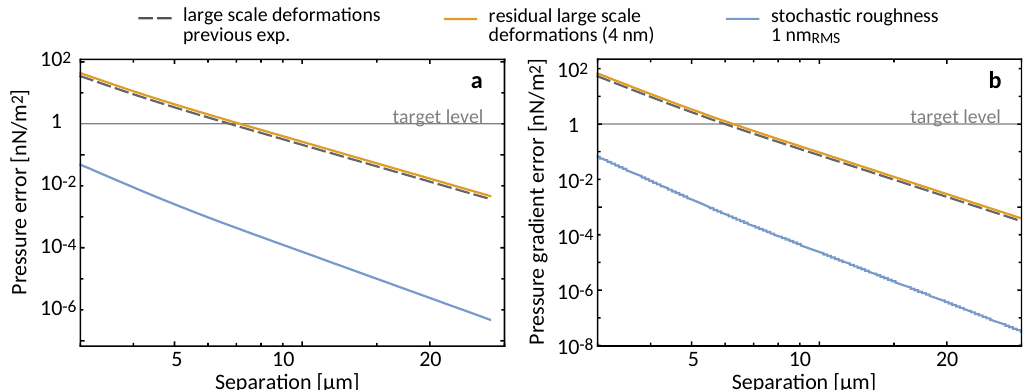
Figure 3. Errors δ P corr of the pressure ( a ) and δ P (cid:48) corr of the pressure gradient ( b ) due to residual large scale deformations of the plates. For reference, the targeted sensitivity level is given by the gray